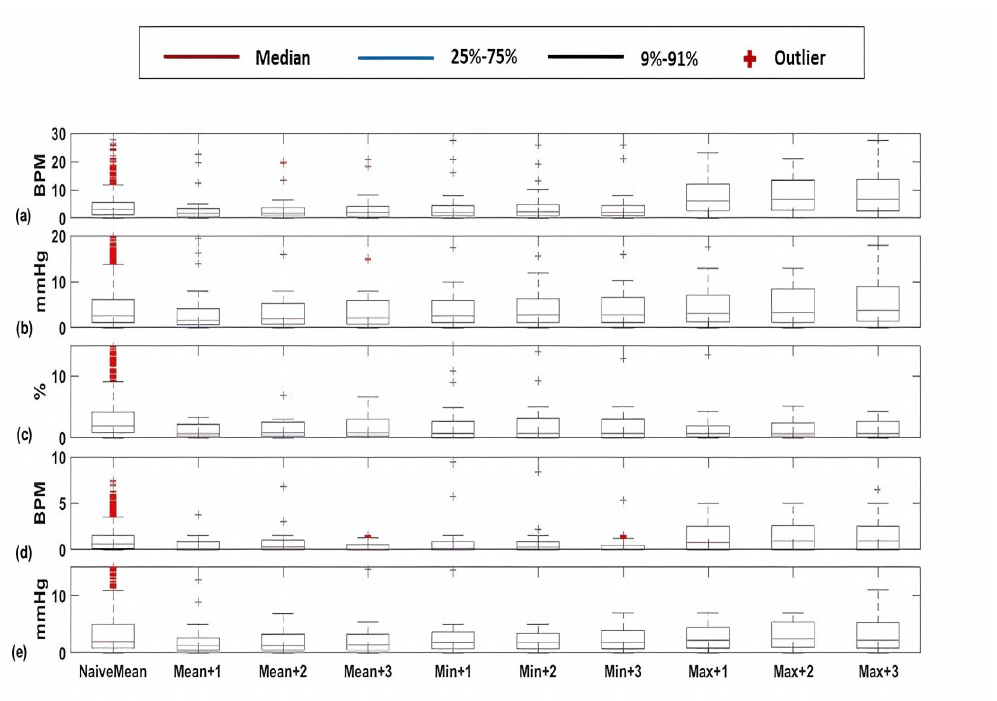
Figure 5. Box-plots of the absolute errors of the Naive predictor at the upcoming hour of the mean value and the proposed algorithm of kNN-LS-SVM of the mean, minimum, and maximum values at the upcoming three hours ( + 1, + 2, + 3 h) for the vital signs ( a ) HR (BPM), ( b ) SBP (mmHg), ( c ) Sp O 2 (%), ( d ) RR (BPM), and ( e ) PP (mmHg) for cardiology